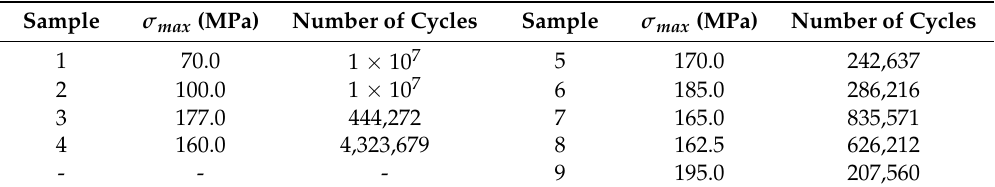
Table 3. S-N curve loading levels applied.